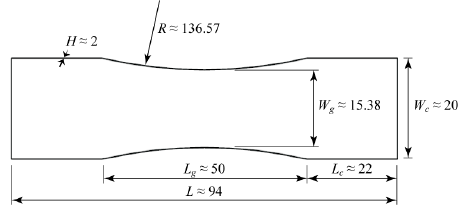
Figure 1. Specimen shape and typical